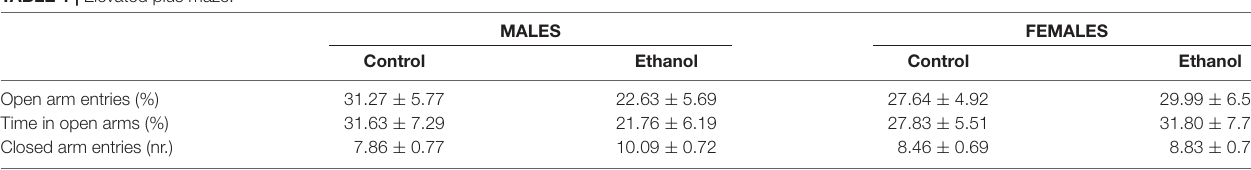
TABLE 1 | Elevated plus maze.